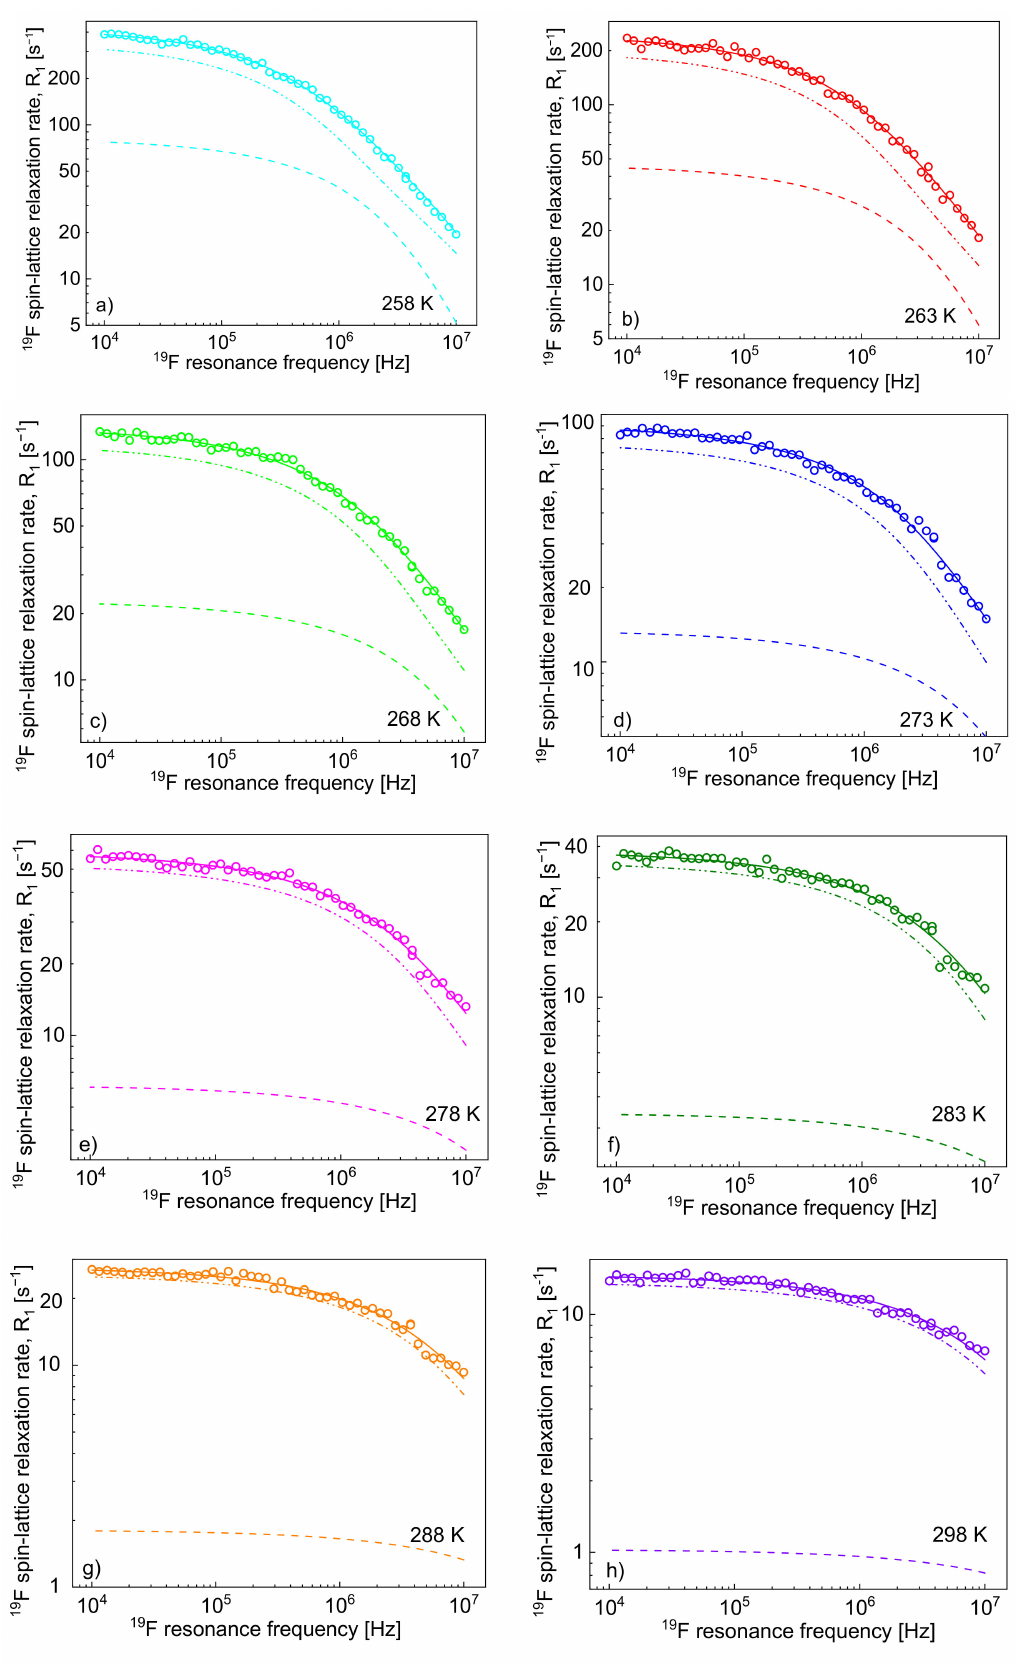
Figure 3. 19 F spin-lattice relaxation rates, R 1, F ( ω F ) , for [TEA-C4][TFSI]; solid lines—theoretical fits decomposed into ( ω ) (dashed lines) and R inter , FH ( ω ) (dashed-dotted-dotted lines) at different temperatures ( a – h R inter , FF F F 1, F 1, F